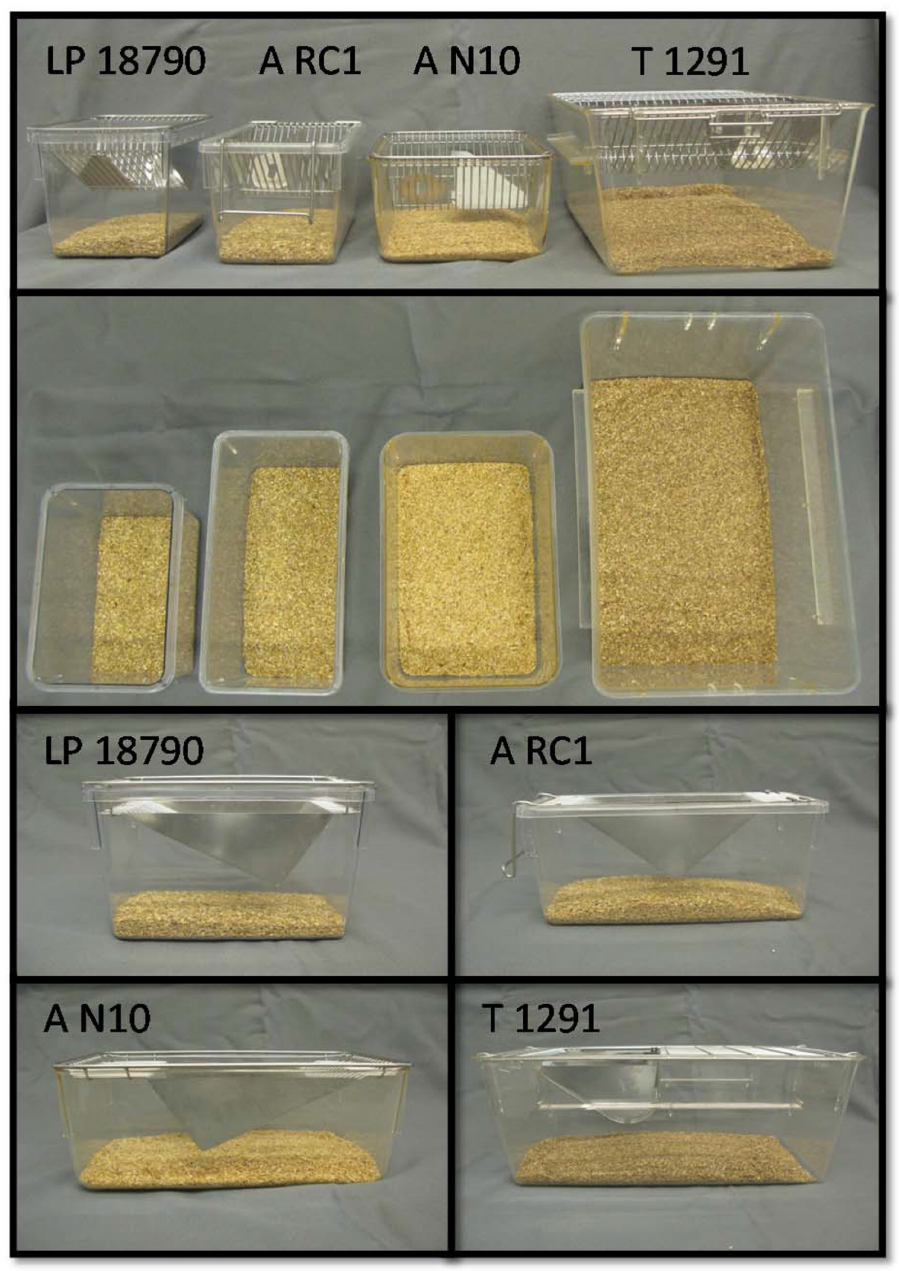
Fig 1. Images of the four different cages used to test if the size of cage altered reproduction or behavior in breeding mice. Top: view of the front of the cages. Cage size increases from left to right. Middle: top view of cages; Bottom grid: Side view of cages